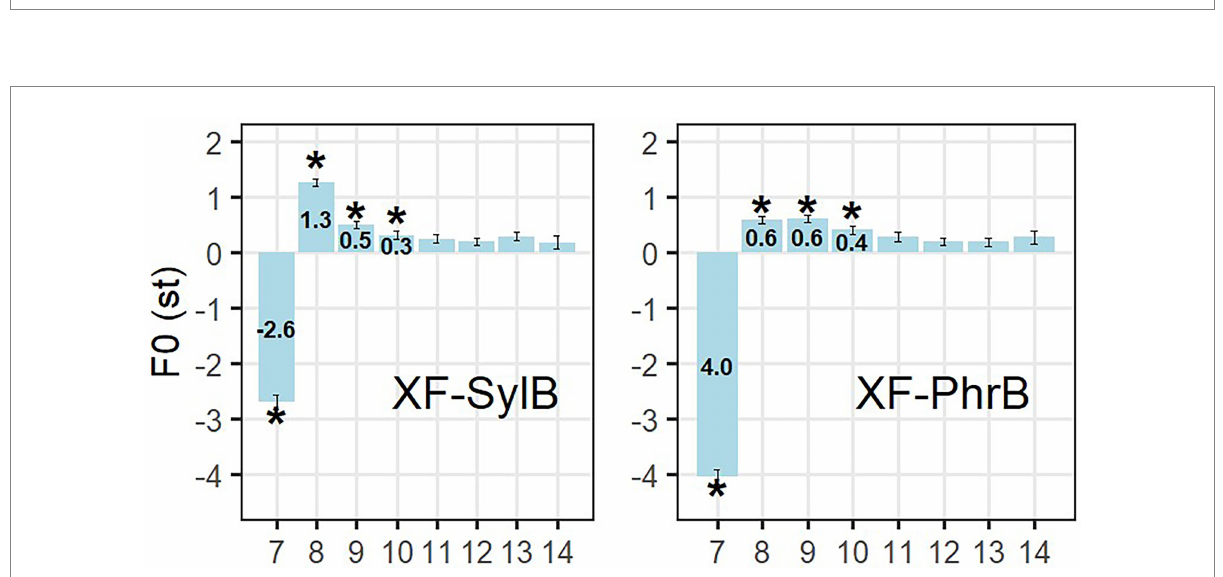
FIGURE 10 Post-low-bouncing effect in the X-focus condition when the boundary between syllable X and Y is either a syllable (SylB) or a phrase (PhrB) boundary. The x -axis shows syllable numbers, in which the 7th is syllable Y, the H tone right after the L